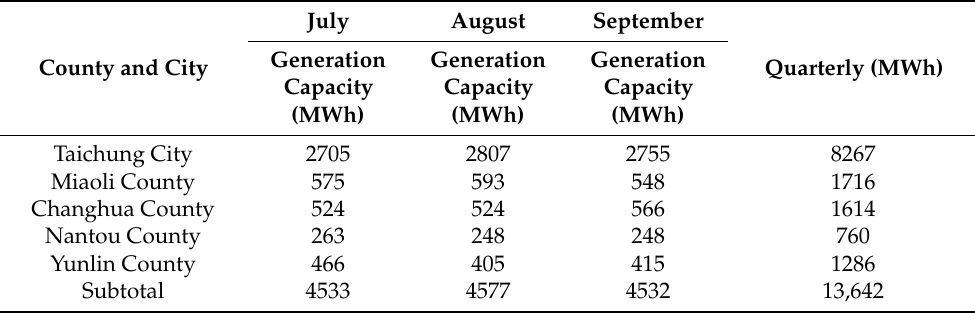
Table 5. The assumed electricity generation based on the actual quantity of kitchen waste treated by anaerobic digestion in the third quarter of 2020 in central Taiwan.